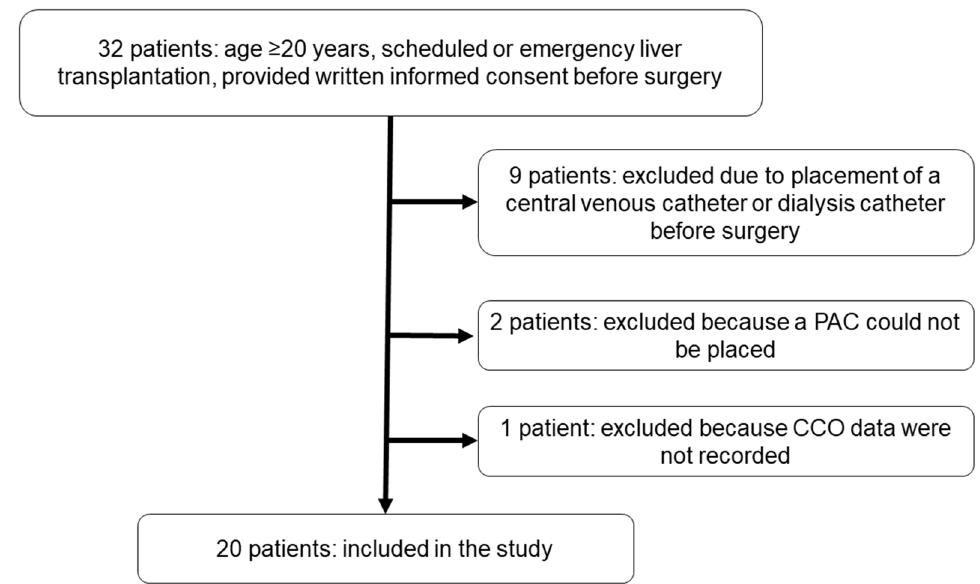
Figure 1. Flow diagram of inclusion and exclusion of patients in the study. A total of 32 patients aged ≥ 20 years old underwent scheduled or emergency liver transplantation. Twelve were excluded due to meeting the indicated exclusion criteria, and 20 were included in the